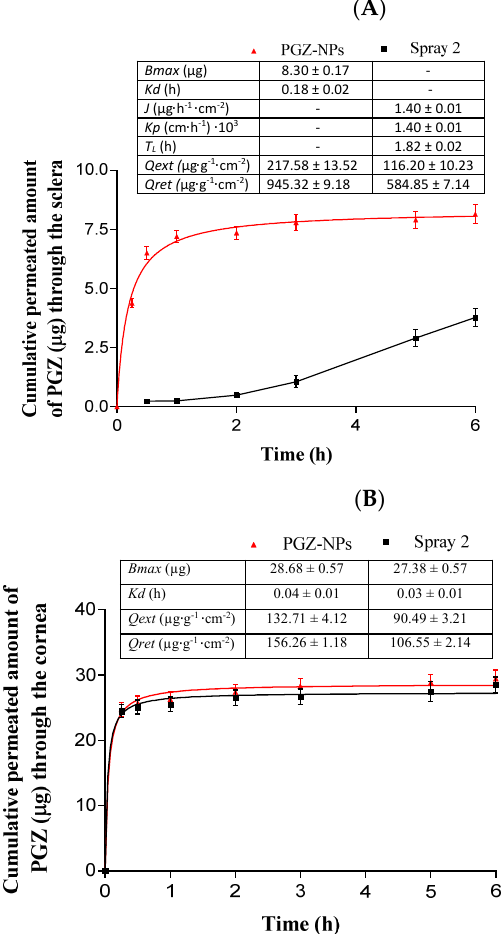
Figure 6. Permeation studies of PGZ-NPs and the Spray 2 formulation in the scleral tissue ( A ) and corneal tissue ( B ). The values are expressed by mean ± SD ( n = 3).